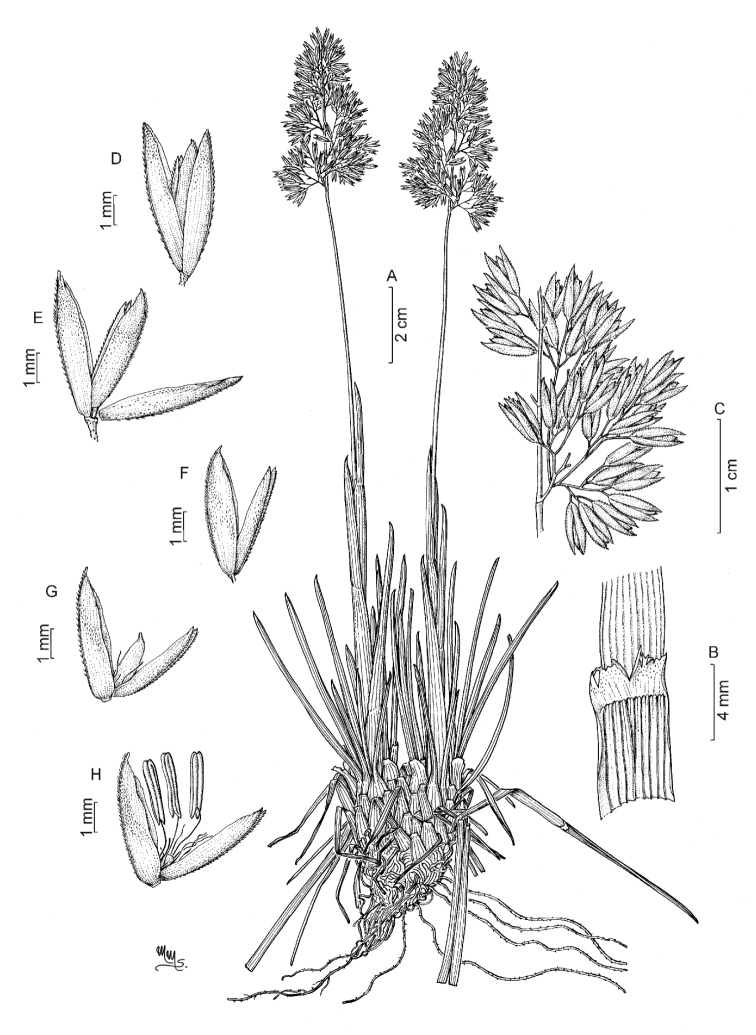
Deschampsiasantamartensis. A Habit B Ligule C Panicle branch D Spikelet E spikelet, with lower glume pulled away to reveal the stipitate floret (extension of the lowermost rachilla internode) F floret G floret, with palea and lemma slightly separated to reveal the ovary in a late stage of development and surrounded by long filamentous trichomes H floret, with palea and lemma slightly separated to reveal the stamens and ovary at an earlier stage of development and surrounded by long filamentous trichomes; drawn by Marcela Morales from the holotype, J. Cuatrecasas & R. Romero Castañeda 24607 (COL).